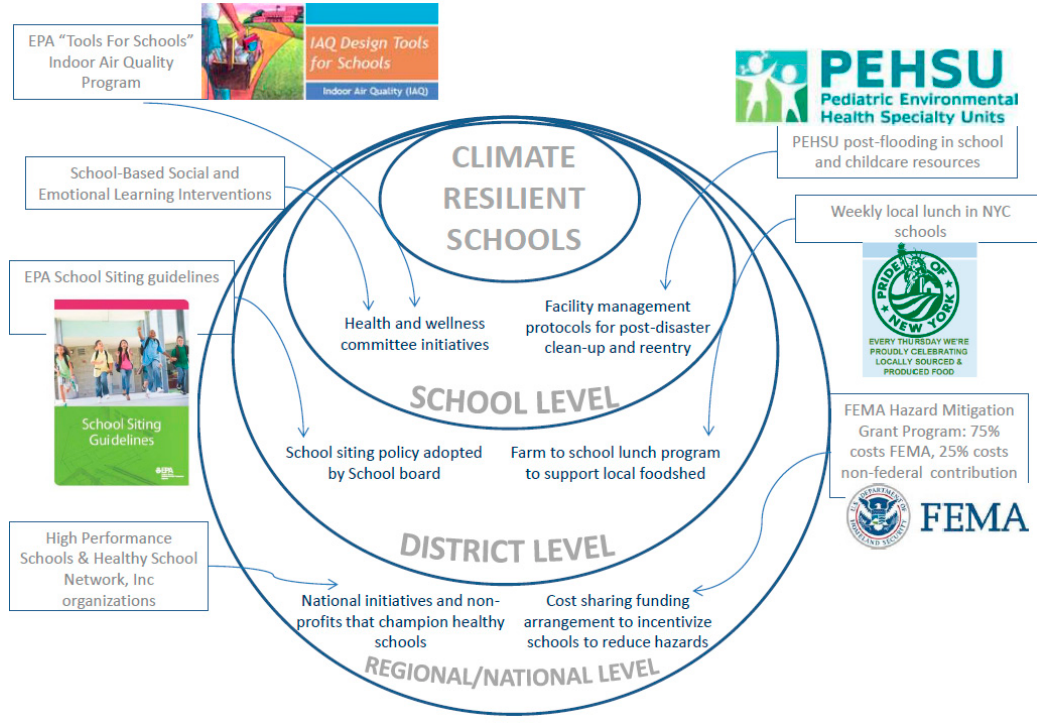
Figure 3. Socio-ecologic model showing the multiple levels from individual school to regional/national initiatives that influence schools’ resilience to climate. Adapted from Ecological Systems Theory model [78].